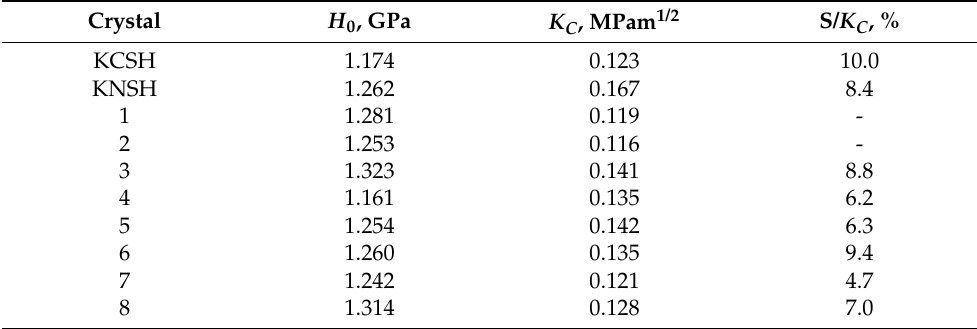
Table 3. Microhardness H 0 , fracture toughness K C , and its standard deviation S for the (110) plane of KCNSH